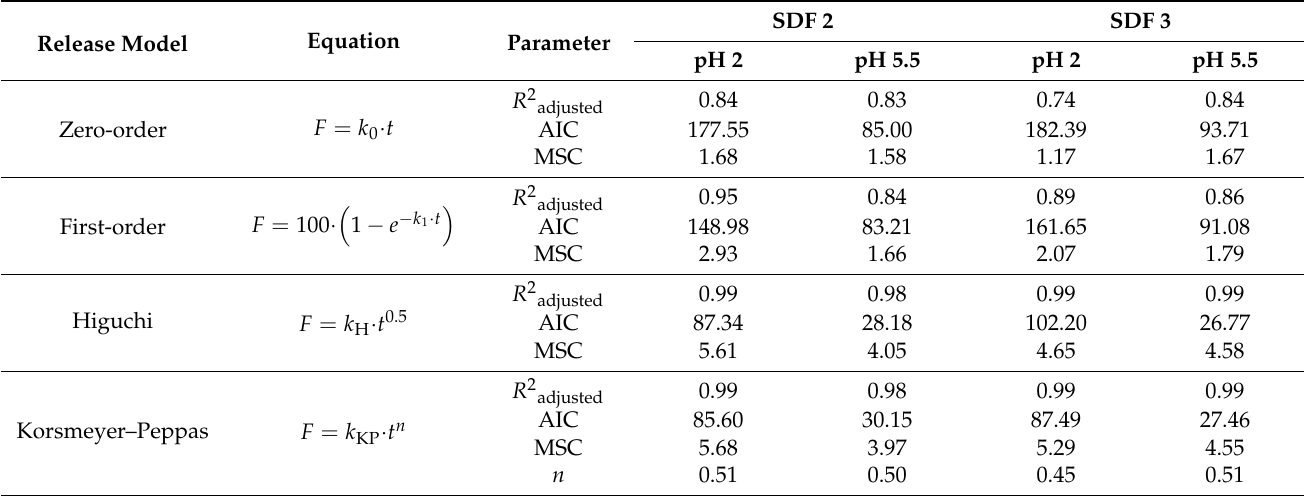
Figure 9. Dissolution profiles of moulded tablets of SDF 2—PEO/FBZ 65% + PCL 35% ( w / w ), fol- Table 4. Kinetic model selection criteria and models’